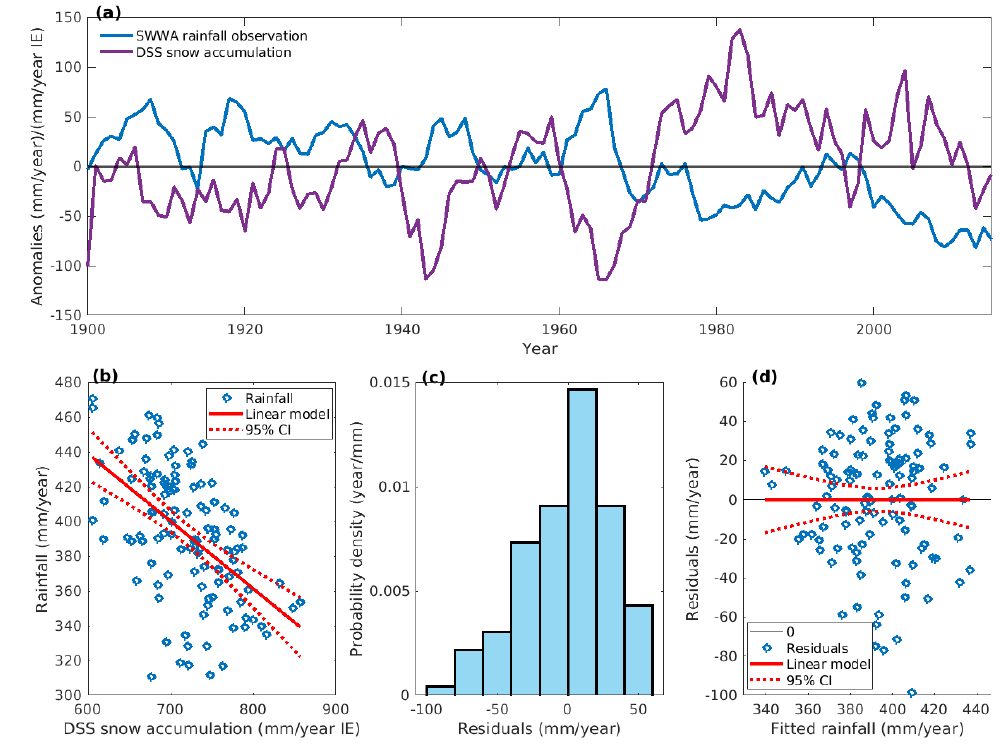
Figure 2. (a) Time series of anomalies for AWAP rainfall in the MASK region and time series of DSS snow accumulation (6-year running averages) for the period from 1900 to 2015CE. (b) Scatter plot of AWAP rainfall in the MASK region and DSS snow accumulation (6-year running averages) for the period from 1900 to 2015CE with their linear models and 95% confidence intervals. (c) The probability density function histogram for the model residuals. (d) Scatter plot for model residuals and fitted data with their linear fits and 95% confidence